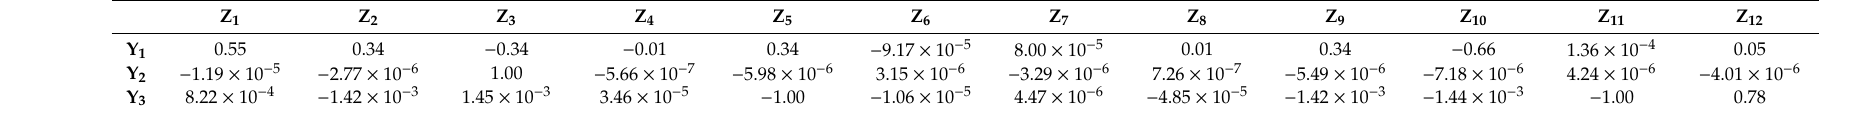
Table 11. Layer weight for intensity feature.